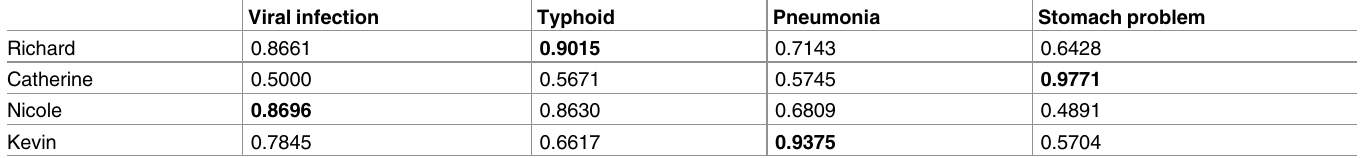
ð H 1 ; H 2 Þ between each patient’s symptoms and possible HFLTS s s s